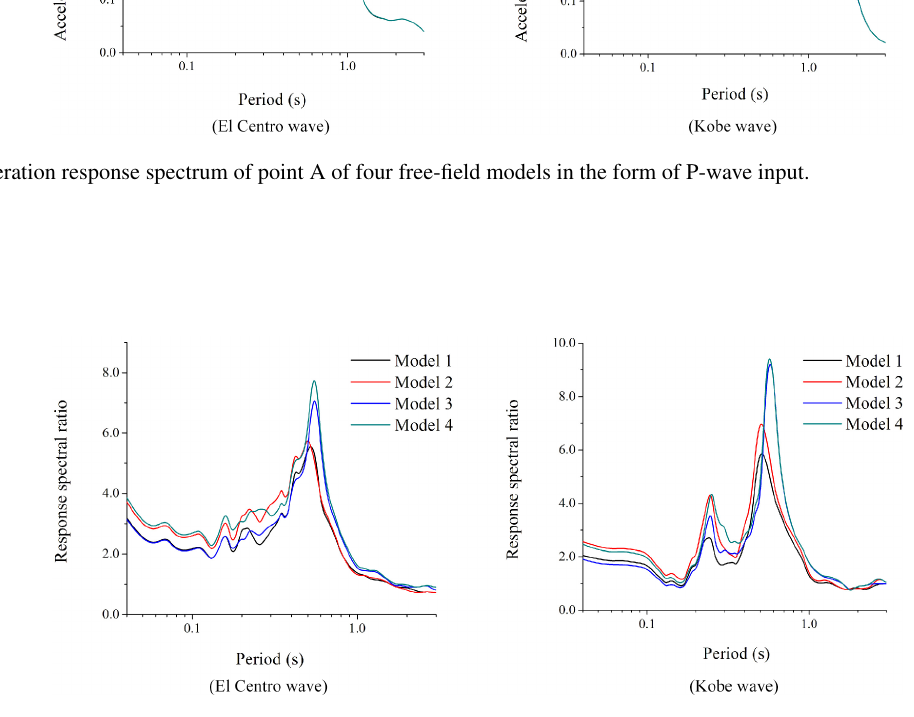
Figure 5. Response spectral ratio between the surface and the base input of an SV wave form.